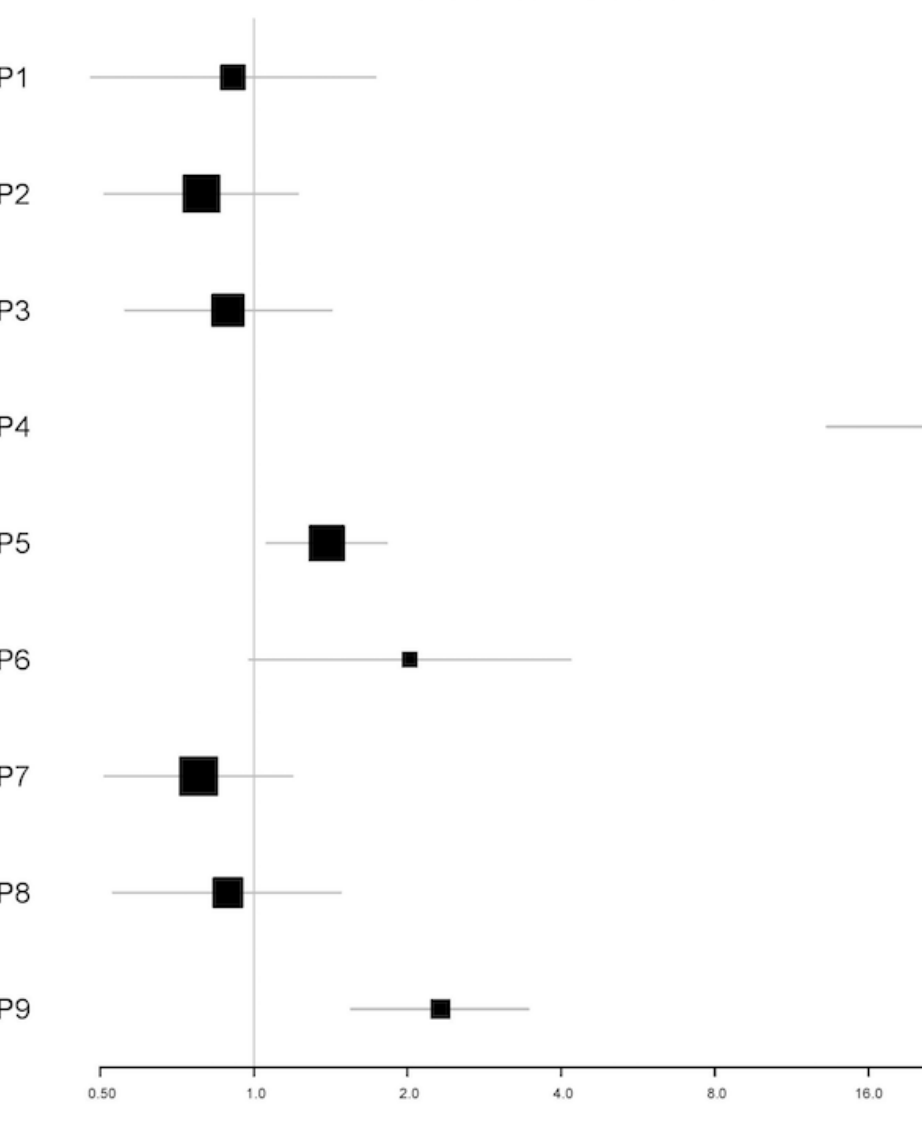
Figure 6. Plot of incidence rate ratios and 95% CIs (x-axis) for the association of perceived usefulness of the app and the amount of engagement for each participant (y-axis) in univariable analyses. P: